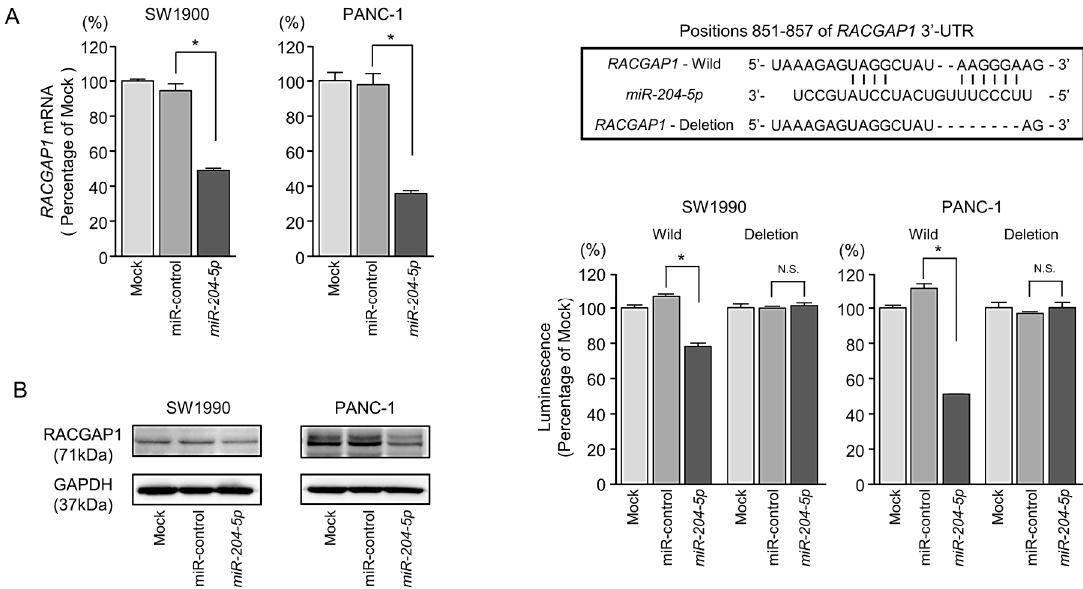
Figure 4. Direct regulation of RACGAP1 by miR-204-5p in PDAC cells. ( A ) RACGAP1 mRNA expression in PDAC cell lines was evaluated by qRT-PCR at 72 h after transfection of miR-204-5p . GUSB expression was evaluated as the internal control. * p < 0.0001. ( B ) RACGAP1 protein expression in PDAC cell lines was evaluated by western blotting at 96 h after transfection of miR-204-5p . GAPDH expression was evaluated as the loading control. ( C ) miR-204-5p binding sites within the 3 ′ -UTR of RACGAP1 mRNA. Dual luciferase reporter assays using vectors harboring either the wild-type RACGAP1 3 ′ -UTR sequence containing the putative miR-204-5p binding site (nucleotide positions 851-857) or the 3 ′ -UTR sequence with deletion of this binding site. Data represent the ratio of Renilla / firefly luciferase activities in PDAC cells transfected with miR-204-5p relative to that in mock-transfected control cells. * p < 0.0001; N.S.: no significant.